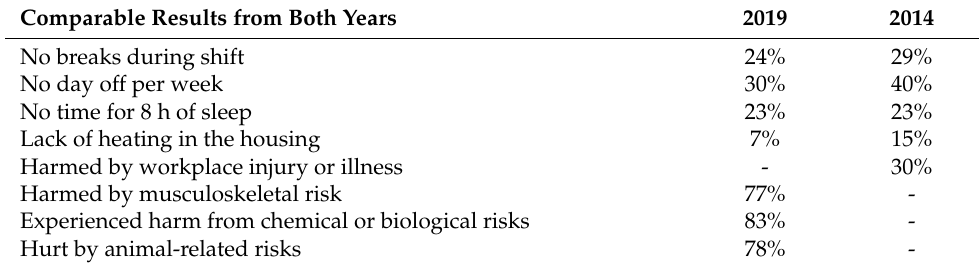
Table 3. Comparable results from the Health and Safety Surveys 2014 and